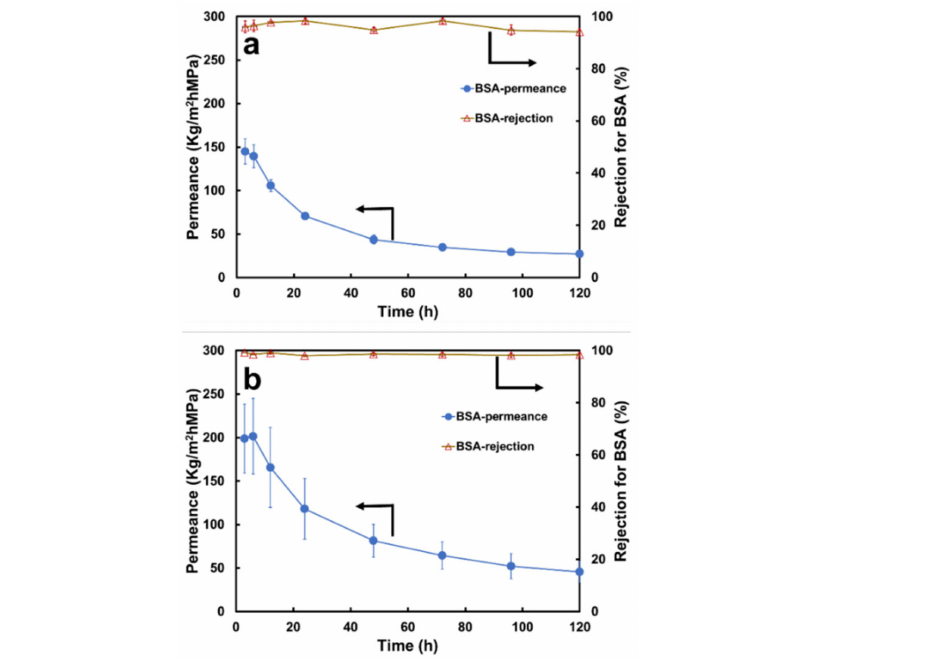
Figure 7. Permeance and rejection of BSA solution using ( a ) non-woven/PVDF-PAA and ( b ) non- woven/PVDF-PAA-GO membranes. The error bars are 95% confidence intervals based on two replicates (n = 2).